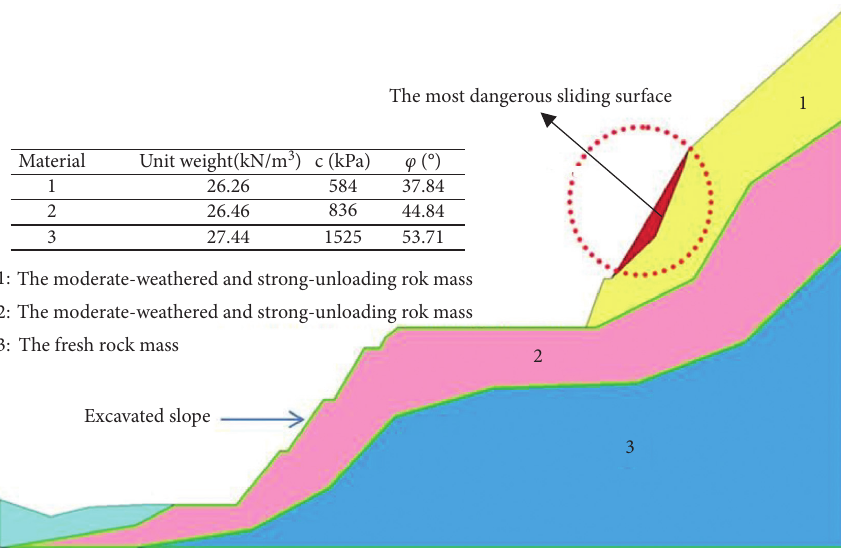
Figure 9: Typical simulation model of slope 2 using the Geostudio software. Table 6: Summary of the stability assessment result using the Geostudio software and the SSPC method. Safety factor values under different Slope Stability assessment result by Geostudio Stability probability by the SSPC